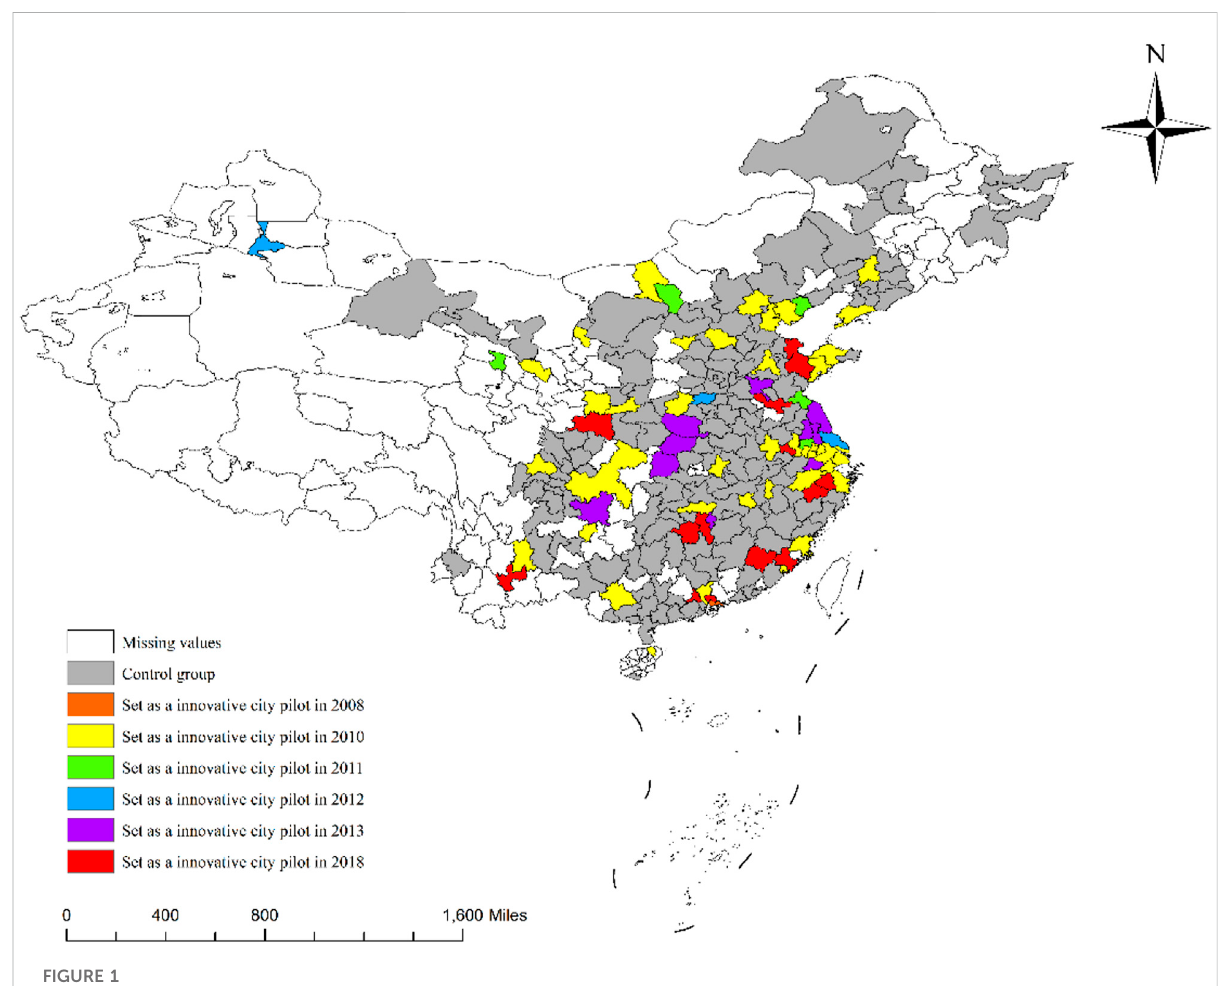
FIGURE 1 Distribution of innovative city pilots in